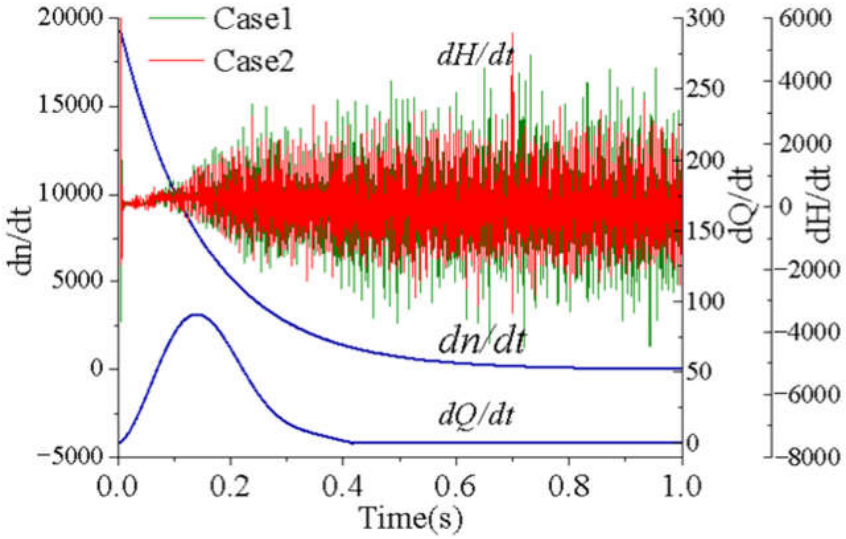
Figure 9. Rate of change in the external characteristics during the startup process.